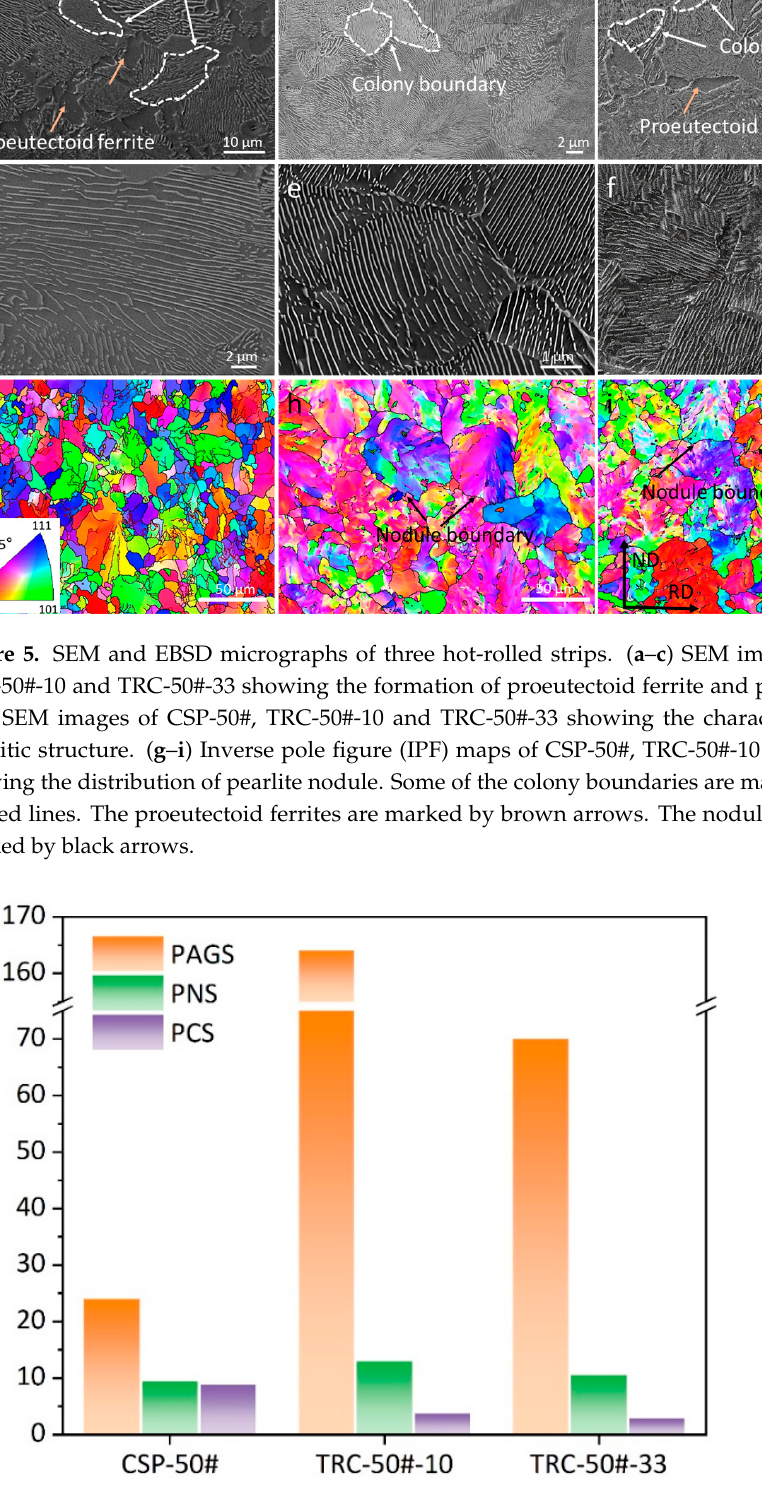
Figure 6. The PAGS, PNS and PCS distributions of the three hot-rolled strips.